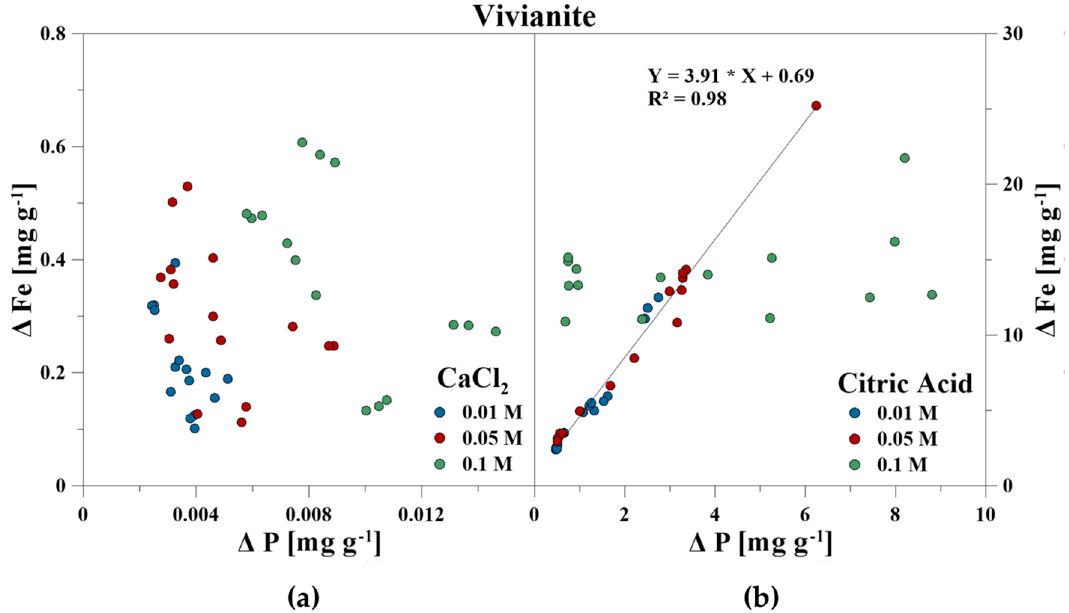
Figure 4. Correlation between dissolved P and Fe during P release using ( a ) CaCl 2 and ( b ) CA from vivianite.